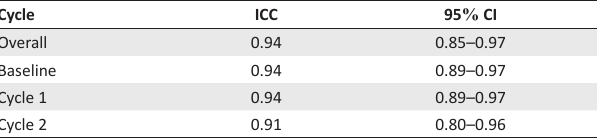
TABLE 6: Intra-class correlation coefficient values through the chemotherapy cycles. Cycle ICC 95 %